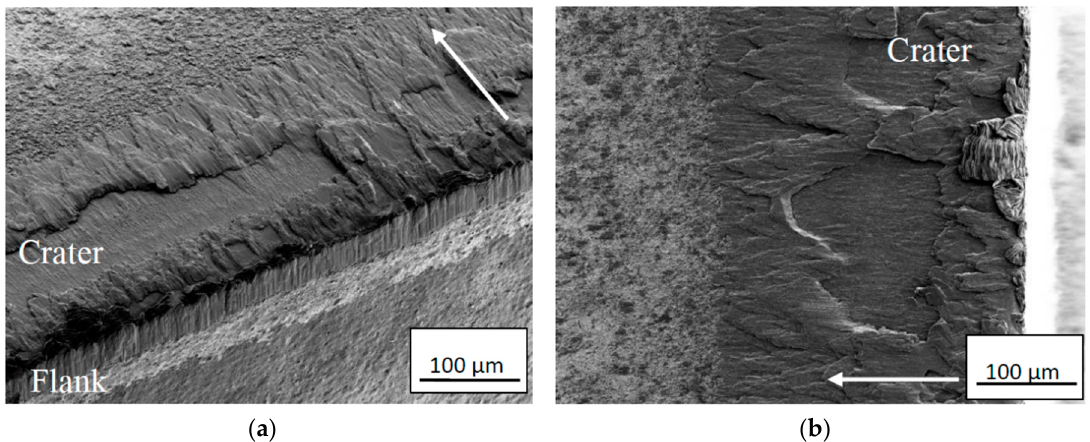
Figure 4. Wear characteristics of cemented carbide insert showing the crater and flank wear region ( a ) and crater ( b ). Cutting parameters: v c : 90 m/min, f n : 0.2 mm, t : 0.5 min. The arrow shows the chip flow direction. Note the transfer of work material to the cutting edge region.